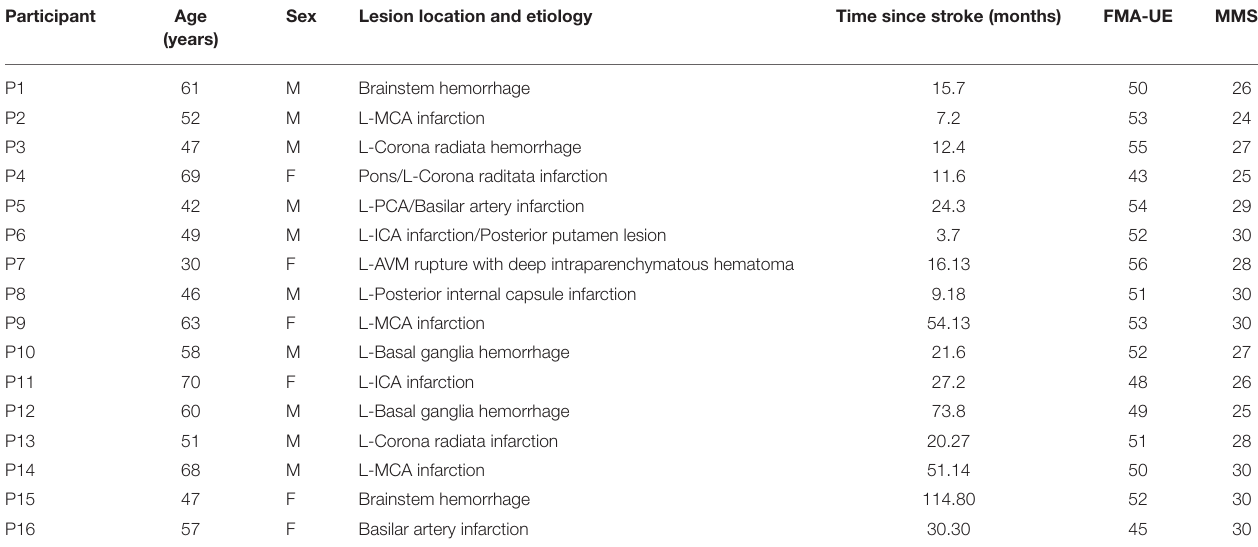
TABLE 1 | Characteristics of study participants.